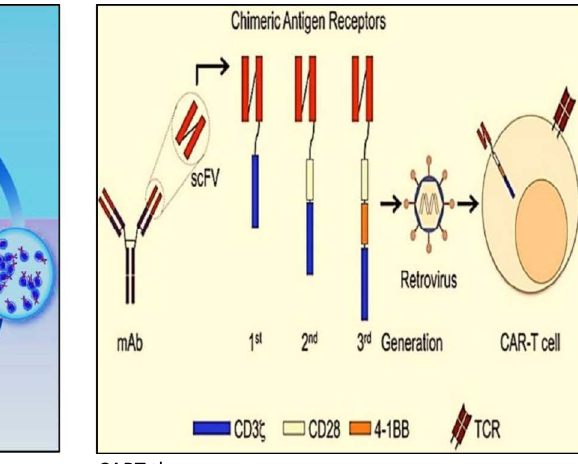
Fig. 3.2. CARs combine with scFVs of monoclonal antibodies. CARs are then inserted to T cells of host via viral mediated gene transfer 23 .